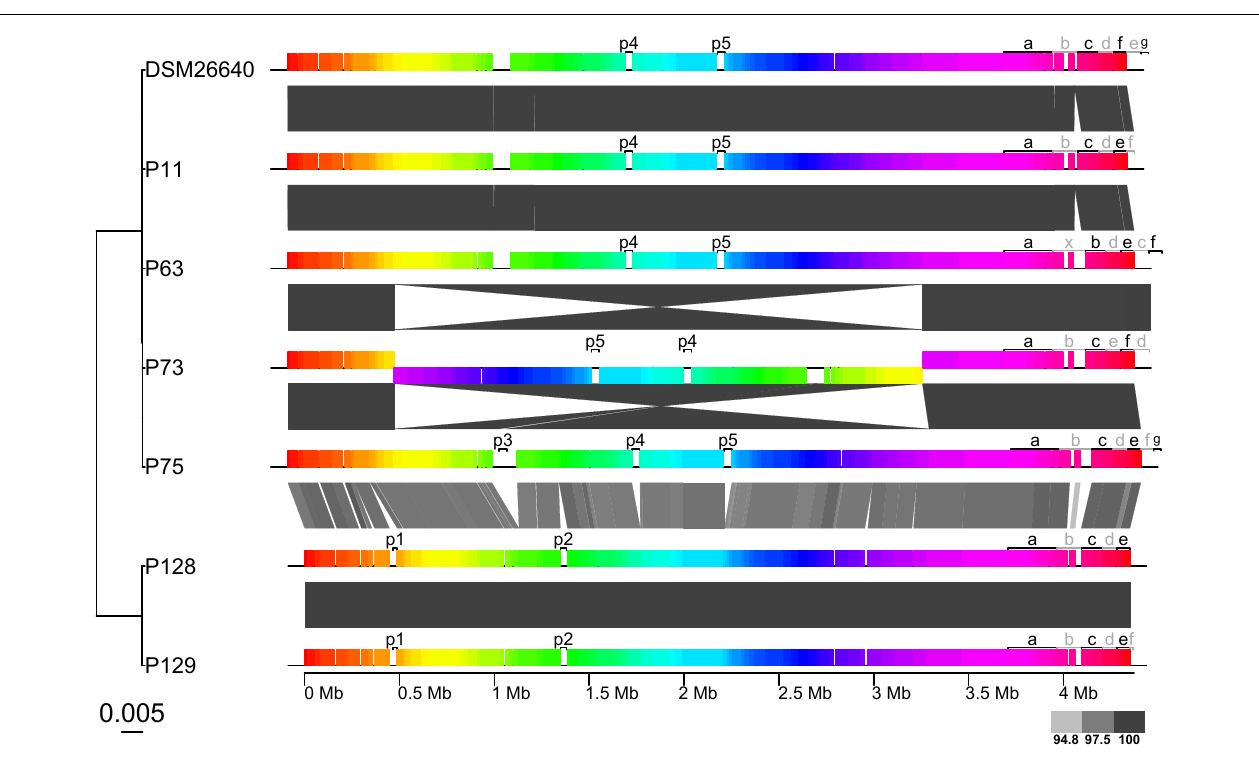
FIGURE 3 | Synteny and sequence similarity of the 7 Phaeobacter gallaeciensis strains. The Mauve alignment depicts large collinear, and presumably homologous blocks as colored rectangles. Collinear blocks cover 87.2–92.4% of the whole genomes. Gray scale of wedges between the genomes indicates the level of sequence identity (%) between genomic blocks. The genome phylogeny on the left was inferred from pairwise genome to genome nucleotide sequence distances (GGDC) using BIONJ and the scale gives the genomic distance. Prophages (labeled p), and plasmids (labeled according to their names, for instance “a” corresponding to pP11_a or pP128_a) are also